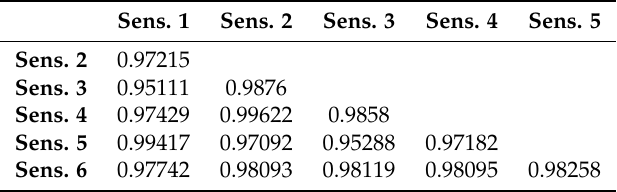
Table 7. Correlation between different instances of DHT22 - Relative Humidity